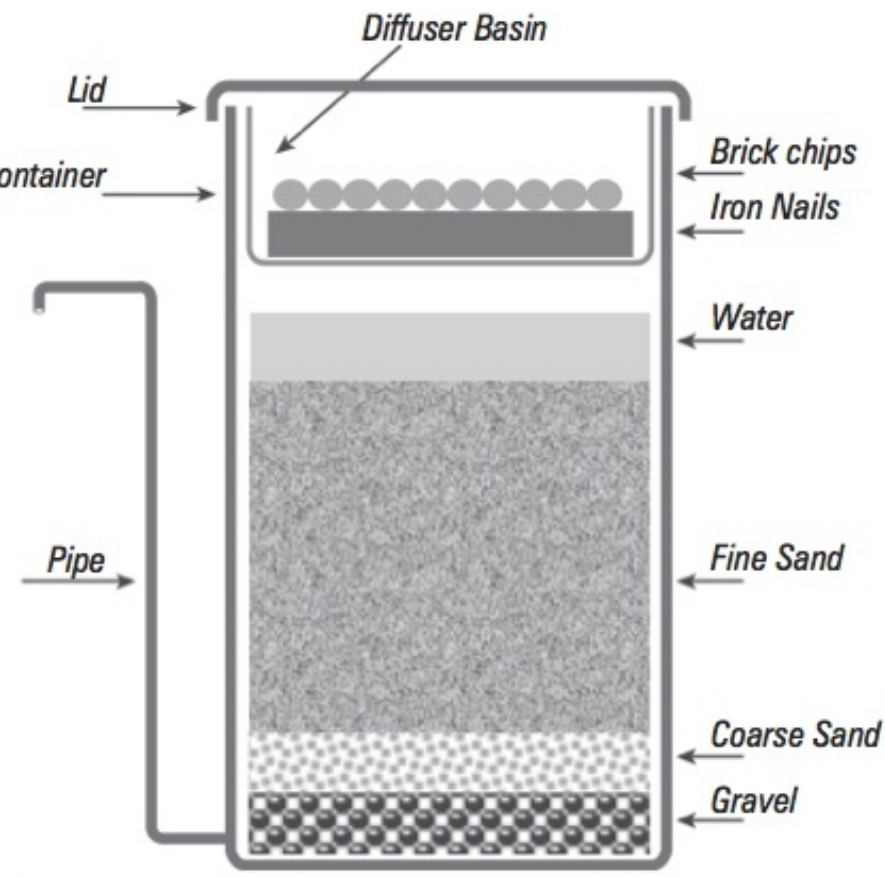
Figure 1. Diagram of the KAF showing the location and arrangement of its components [13].